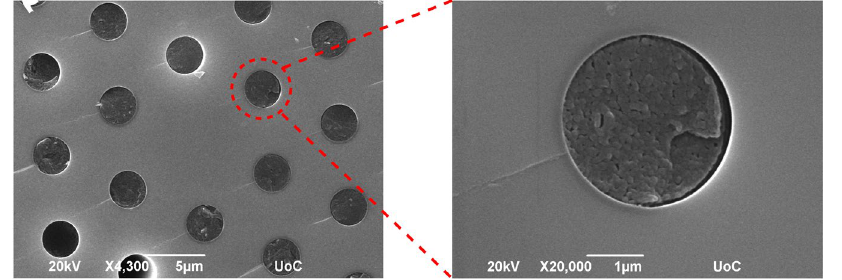
Figure 1. Scanning Electron Microscopy image of the MNA infiltrated fiber. (Left) Area surrounding the optical fiber core. (Right) MNA-filled inner-ring capillary. Infiltration time: 24 h.